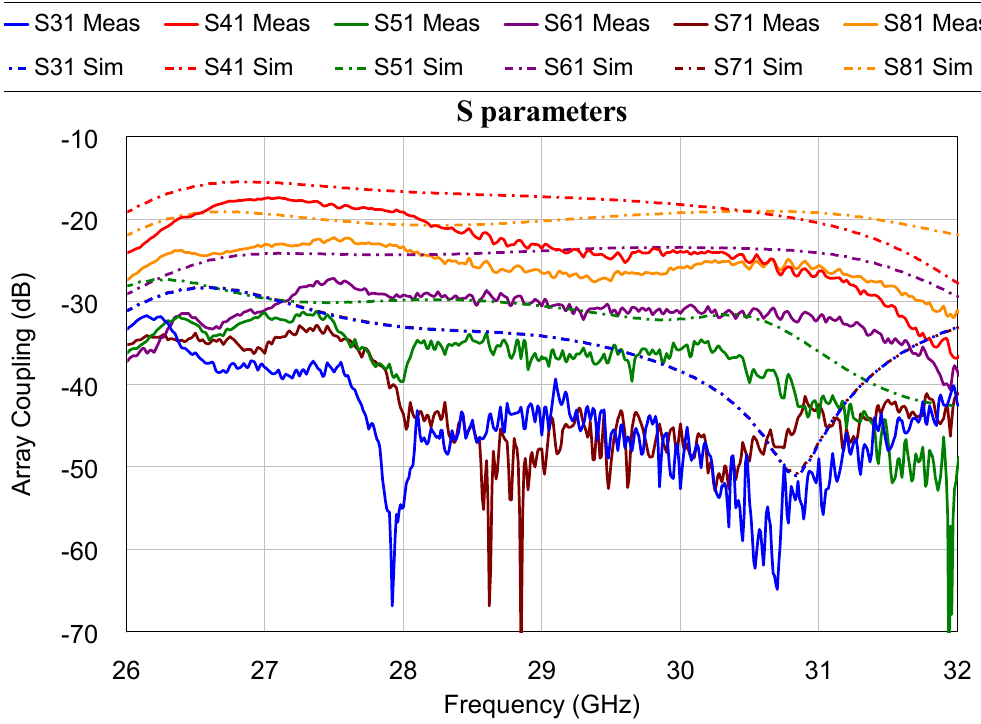
Figure 8. 2 × 2 antenna array configuration ( left ); the manufactured prototype ( right ).